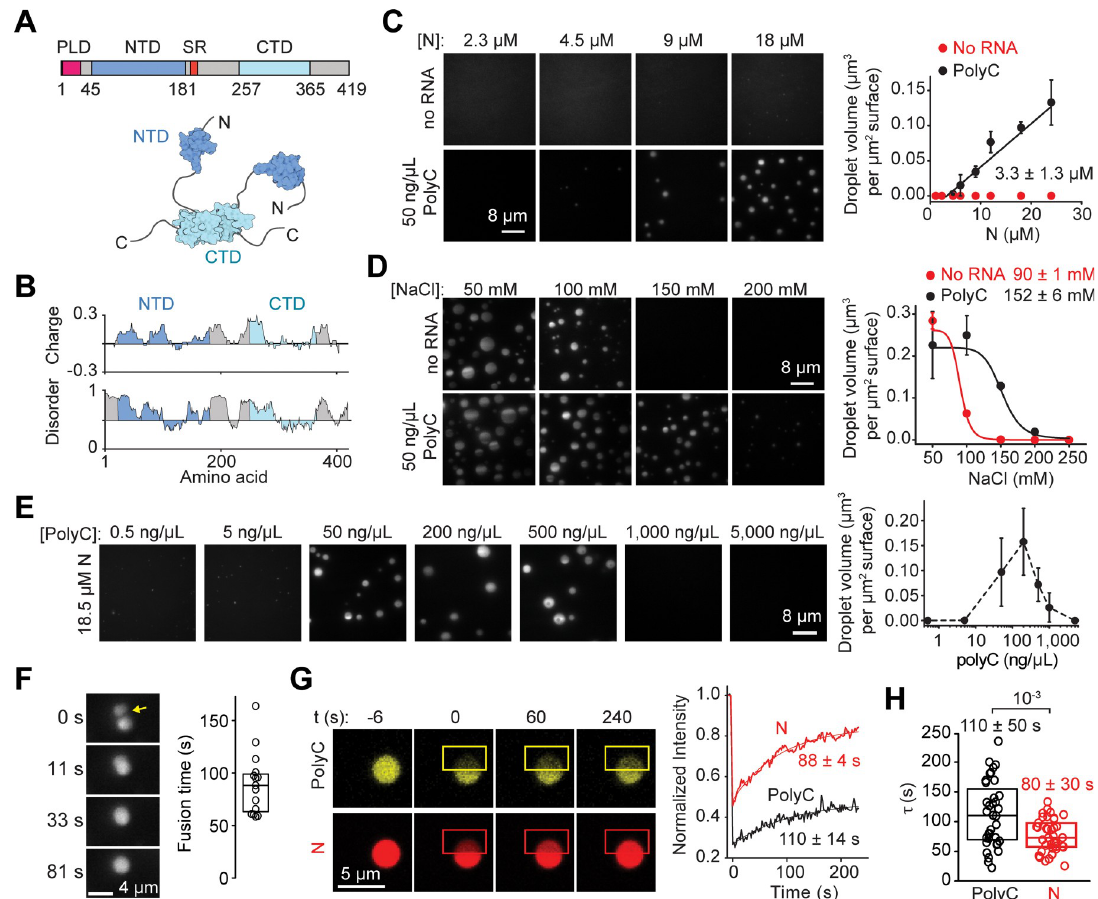
Fig 1. The SARS-CoV-2 N protein phase separates with RNA in vitro. (A) Domain organization and the schematic of the N protein dimer. (B) Sliding window plot of charge distribution (EMBOSS) and disorder prediction (IUPred2A) for the N protein. Charge y-axis represents mean charge across a 30-residue sliding window. Disorder prediction (1, disordered; 0, ordered) was calculated using the “long disorder” setting, encompassing a 30-residue sliding window. (C) (Left) Images of the LD655-labeled N protein in the presence and absence of polyC RNA in 150 mM NaCl. (Right) The total volume of N-RNA condensates settled per micron squared area on the coverslip with and without 50 ng/ μ L polyC RNA (mean ± SD, n = 20 with 2 technical replicates). A linear fit (solid line) reveals c sat ( ± SE), the minimum N protein concentration for condensate formation (see Methods). (D) (Left) Condensates formed by 24 μ M LD655-labeled N protein in the presence or absence of 50 ng/ μ L polyC RNA dissolve by increasing NaCl concentration. (Right) The total volume of N condensates settled per micron squared area on the coverslip with increasing salt concentration (mean ± SD, n = 10). Solid curves represent a fit to a dose–response equation to determine IC 50 ( ± SE). (E) The stoichiometry of the N protein and RNA affects phase separation. (Left) Example pictures show that Cy3-labeled N protein forms condensates with different concentrations of polyC RNA. The N protein concentration was set to 18.5 μ M. (Right) The total volume of N-polyC condensates settled per micron squared area on the coverslip under different RNA concentrations (mean ± SD; n = 20, 2 technical replicates). (F) (Left) The fusion of N- polyC condensates formed in the presence of 18.5 μ M LD655-labeled N and 50 ng/ μ L polyC RNA. (Right) Fusion time of N-polyC condensates (mean ± SD, n = 15 fusion events). The center and edges of the box represent the median with the first and third quartiles. (G) (Left) Representative FRAP imaging of an N-polyC condensate. The image of a condensate before the time of photobleaching (0 second) shows colocalization of Cy3-polyC and LD655-N in the condensate. Rectangles show the photobleached area. (Right) Fluorescence recovery signals of N and polyC in the bleached region. Solid curves represent a single exponential fit to reveal the recovery lifetime ( τ , ± 95% confidence interval). (H) The distribution of fluorescence recovery lifetimes of N and polyC in droplets ( n = 37). The center and edges of the box represent the median with the first and third quartiles. The p -value was calculated from a 2-tailed t test. Data underlying this figure can be found in S1 Data. CTD, carboxyl-terminal domain; N, nucleocapsid; NTD, N-terminal domain; PLD, prion-like domain; SARS-CoV-2, Severe Acute Respiratory Syndrome Coronavirus 2; SR, serine/arginine-rich.